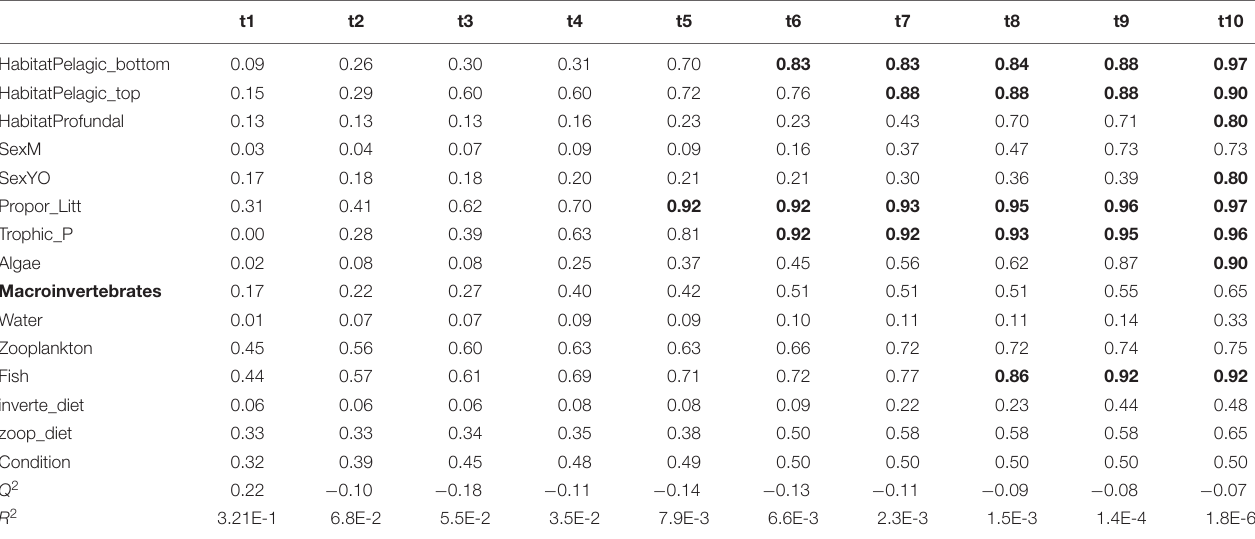
TABLE 3 | Results from PLS model 2 tested relationship between perch body condition with both environmental and dispersal factors. t1